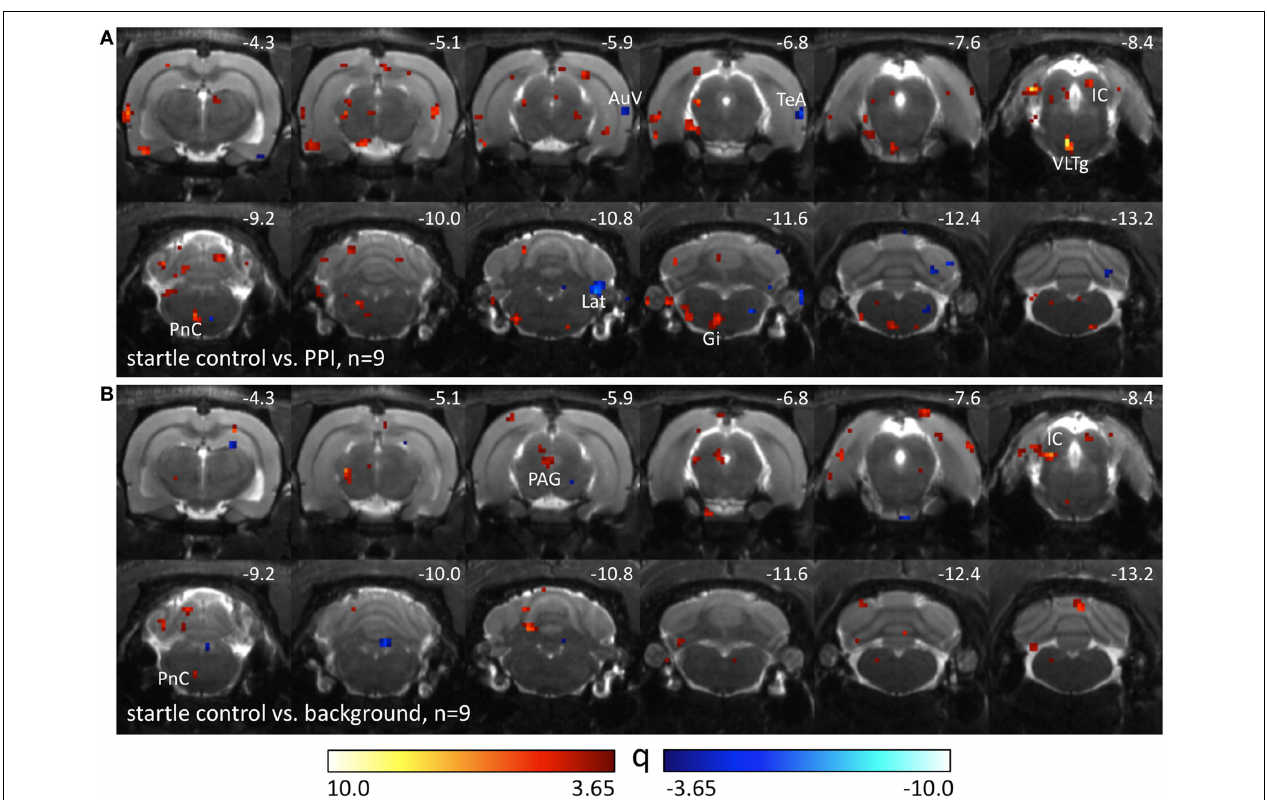
FIGURE 3 | Comparison of different PET sessions in well-hearing Black hoodedrats. Q-mapsresultingfromTukey post-hoc testsfollowingaOne-Way repeated measures ANOVA which compare images from the startle control PET session with those from (A) PPI and (B) background control sessions. Red color indicates voxels with higher FDG uptake in the startle control PET